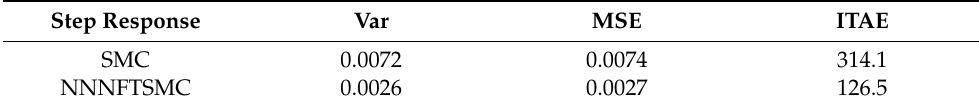
Table 1. Results of SMC and NNNFTSMC for periodic response.